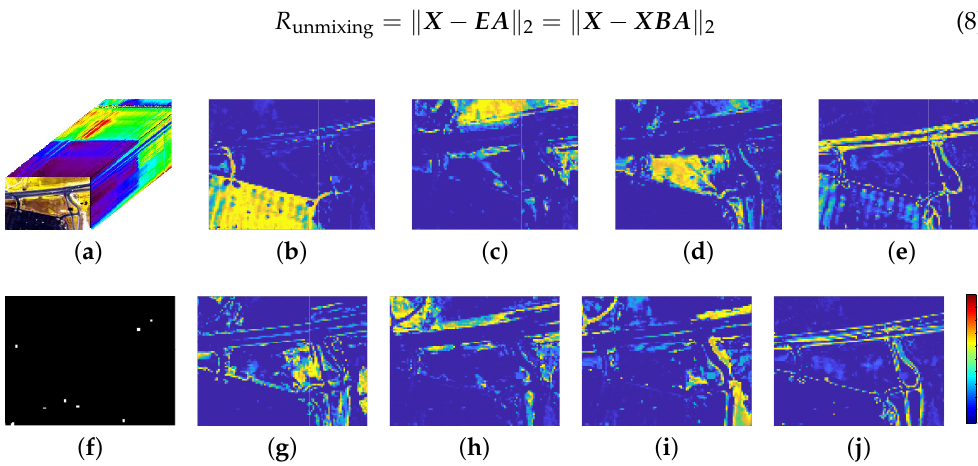
Figure 1. Two-dimensional abundance map achieved by unmixing of a sub-image of a public hyperspectral dataset “Urban” (introduced in following Section 3.1.2). ( a ) Original data. ( b – e ) Abundance maps for the 1st, 2nd, 3rd and 4th background materials. ( f ) Ground truth of the abnormal targets (cars and roofs) which were embedded in the different background types. ( g – j ) Abundance maps for the 5th, 6th, 7th and 8th background